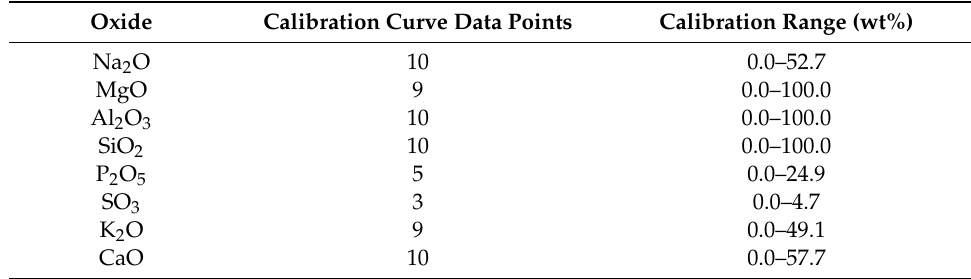
Table 2. Numbers of data points and calibration ranges for the elemental oxide standards used in our OXI Wide Range Oxide XRF